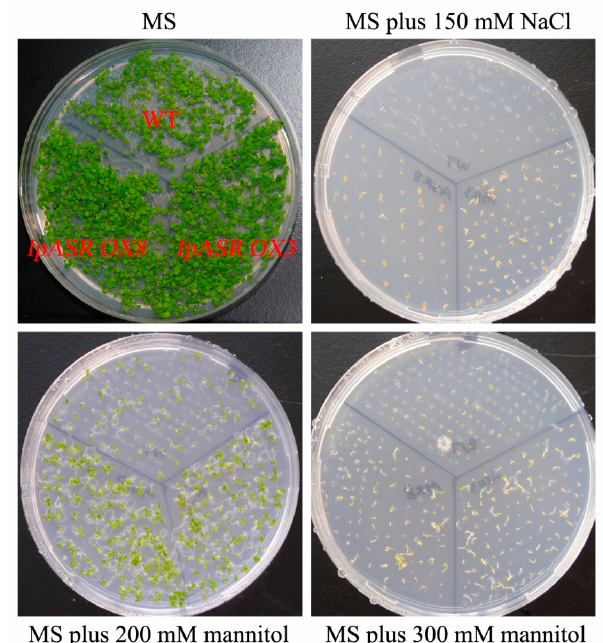
Figure 9. Photographs of transgenic lines ( IpASR OX3 and IpASR OX8 ) and WT seeds germinated on MS medium or MS medium with mannitol (200 and 300 mM) or NaCl (150 mM) for 3 weeks.